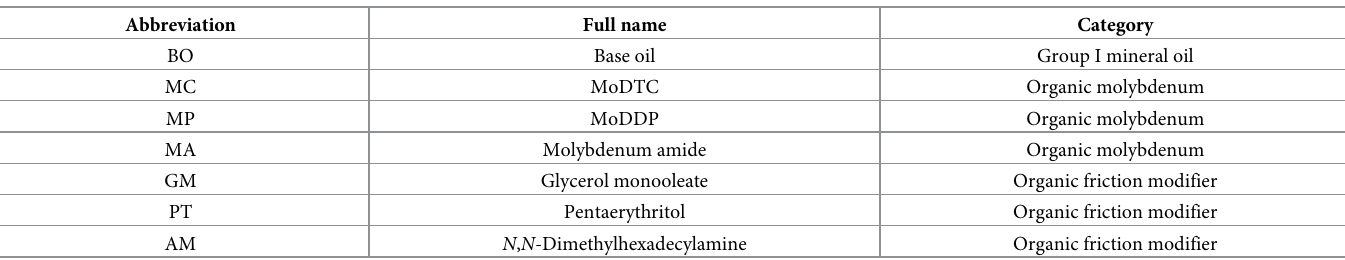
Table 1. Base oil and additive abbreviations.